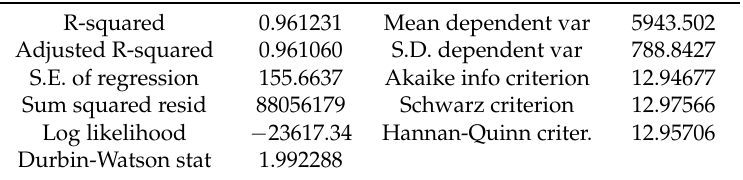
Table 6. Evaluation of the SARIMAX model for estimation set in the period